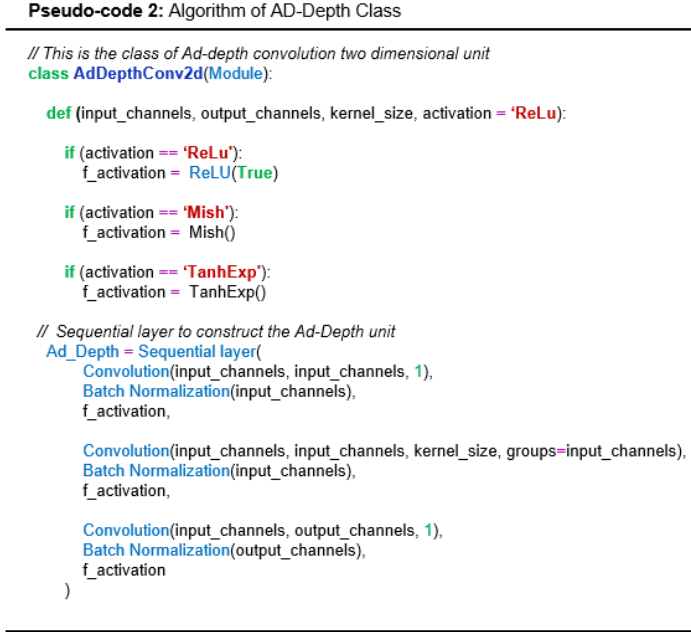
Figure 14. Algorithm of AD-Depth class.